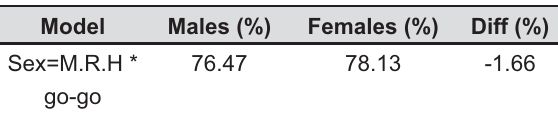
Table 4- Logistic regression: method of Oliveira, et al. 15 (1995) Model Discriminate function P Sex=M.R.H